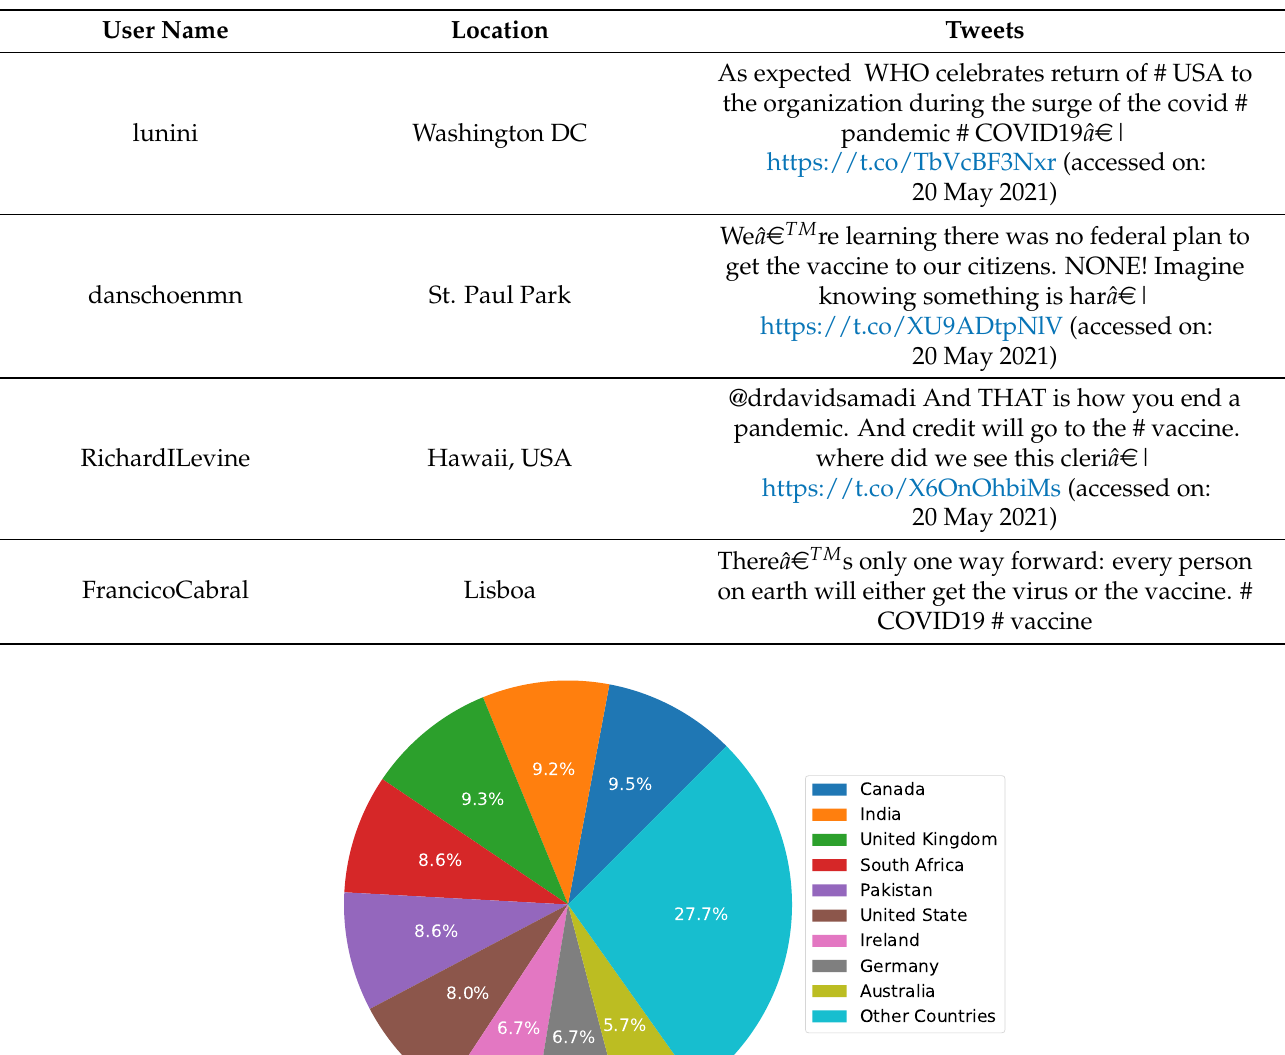
Table 1. Sample text from tweets dataset.